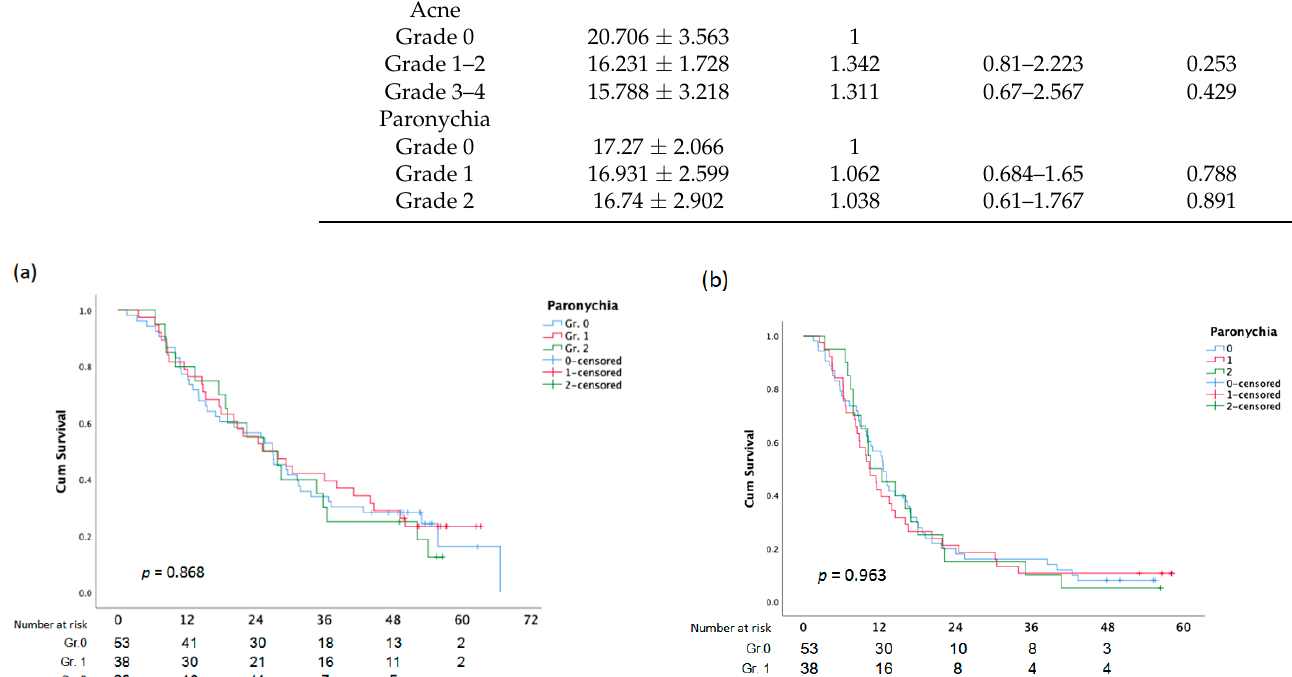
Figure 1. Overall Survival ( a )and PFS ( b ) analysis according to Acne.